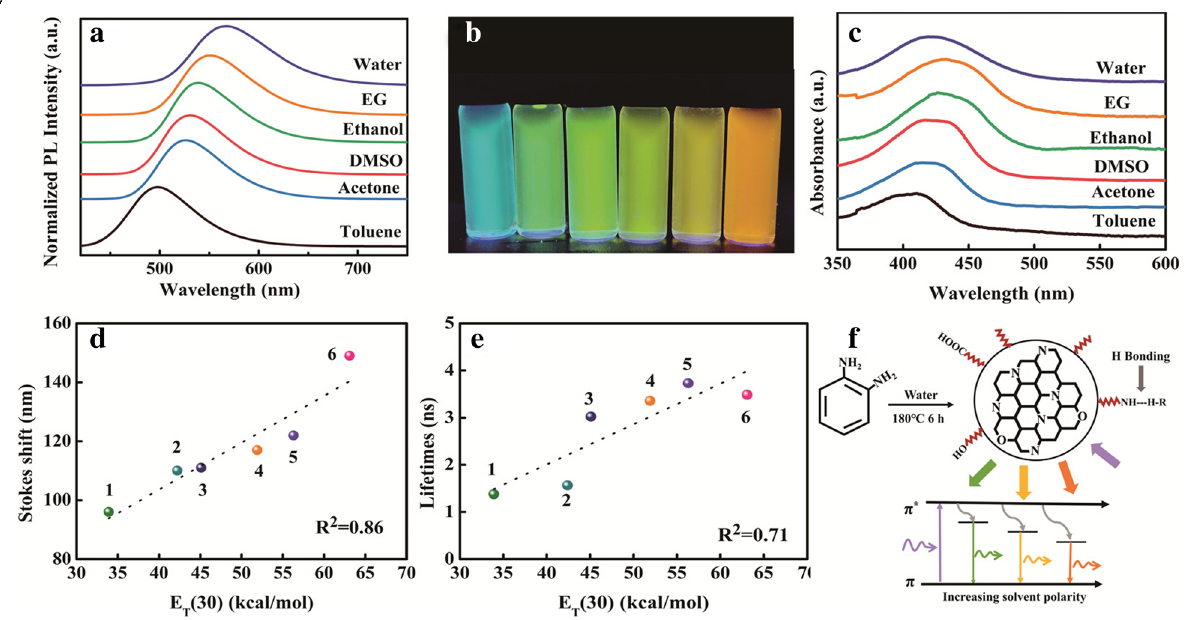
Fig. 2 a Normalized PL spectra of NCDs in six solvents, λ ex = 400 nm. b Digital photograph of NCDs in six solvents under an UV lamp. c Absorption spectra of NCDs in six solvents. Relationship between the spectral parameters and E T (30): d Stokes shifts and e lifetimes. f Schematic illustration of the interaction between surface functional groups and solvents. Solvents used are as follows. 1: toluene, 2: acetone, 3: DMSO, 4: ethanol, 5: EG, 6: